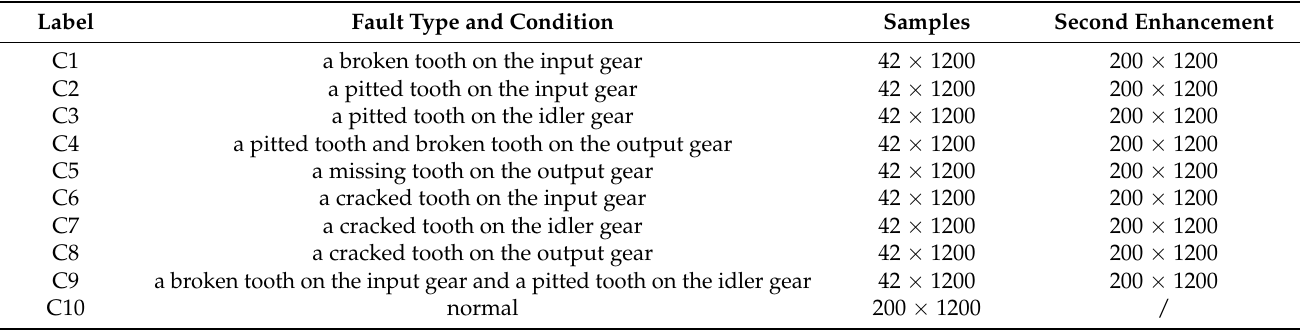
Table 6. Introduction to gear data sets.